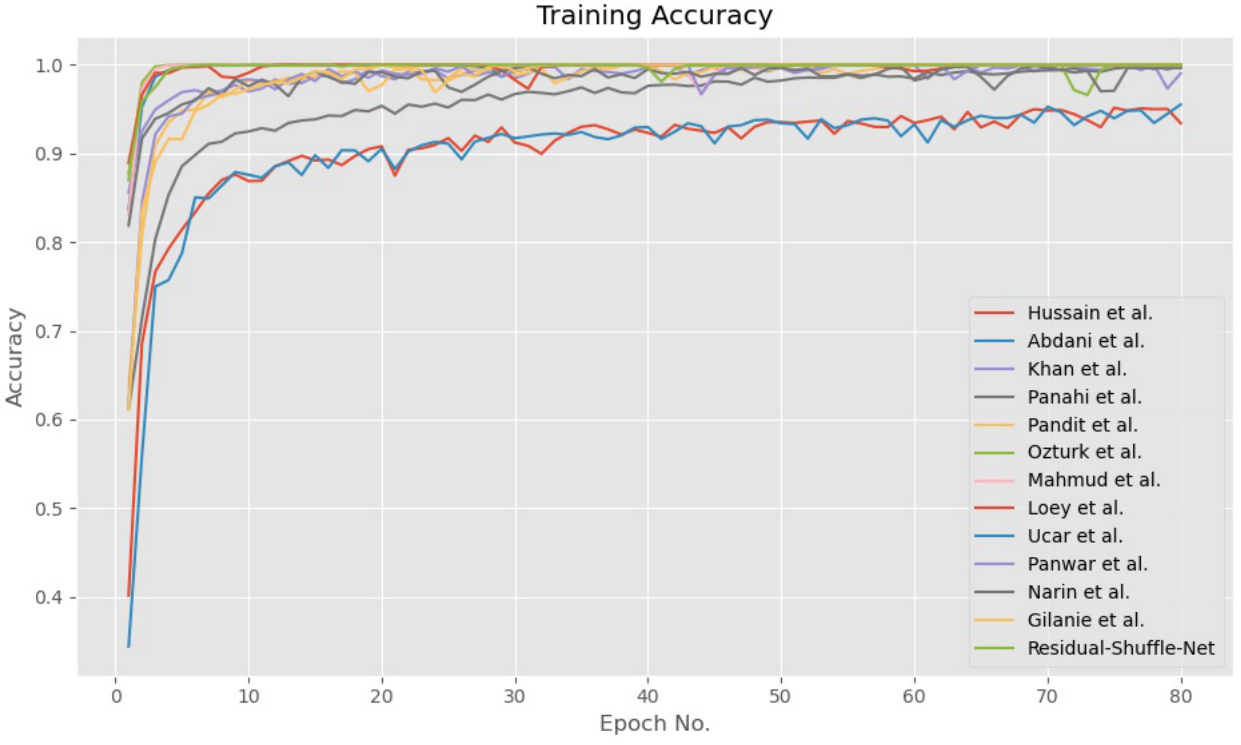
Figure 5. Training accuracy for Residual-Shuffle-Net and all of its benchmark methods.